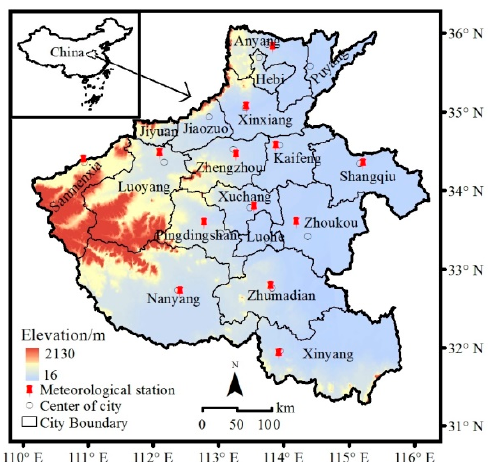
Figure 1. Map of Henan Province in China including the locations of the 18 cities and 13 meteorological